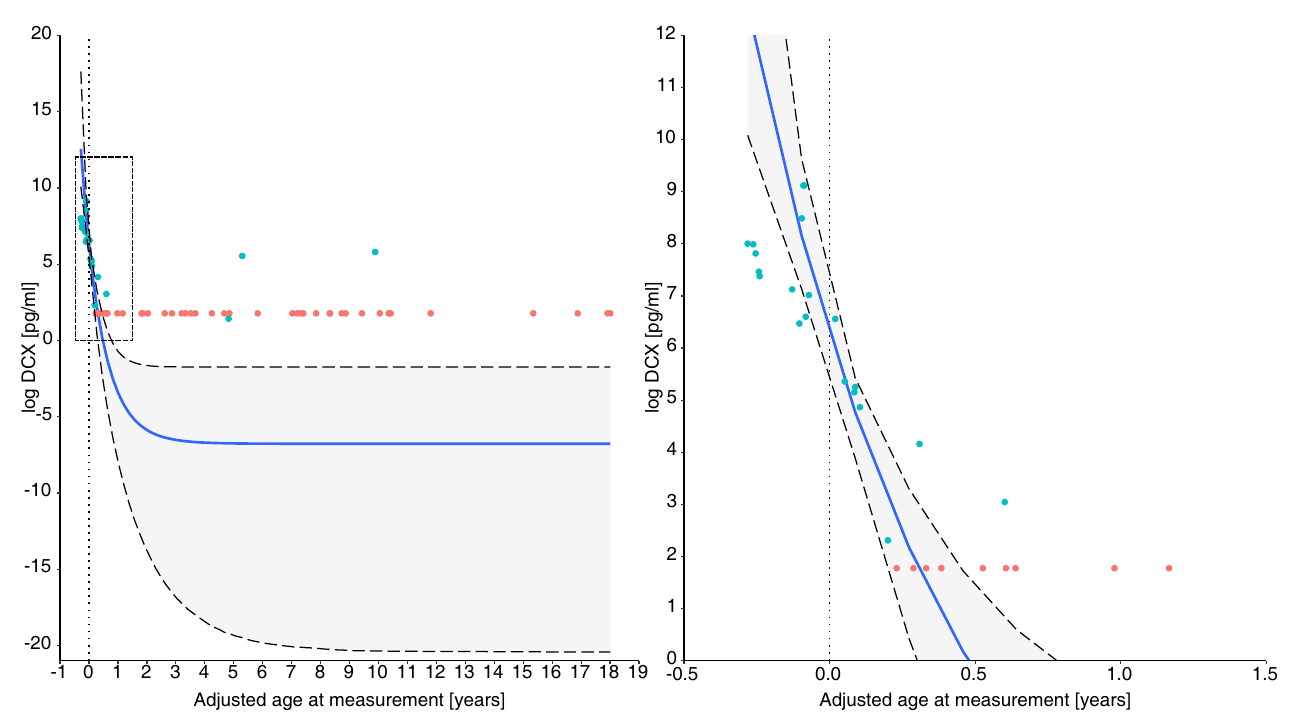
Fig 1. Log concentration of DCX by term-born adjusted age at measurements (years). The graph on the left shows the asymptotic relationship between CSF-DCX and age, and the right panel corresponds to the zoomed view of the dashed rectangle in the left graph. The blue line is the regression fitted curve and the grey area represents the 95% credible interval. Blue dots represent values over, and red dots below the limit of detection. The censored values are displayed as the mean value of the LOD of all DCX assays, and hence all align. One blue dot is below the mean LOD because it was within detectable range in the corresponding assay